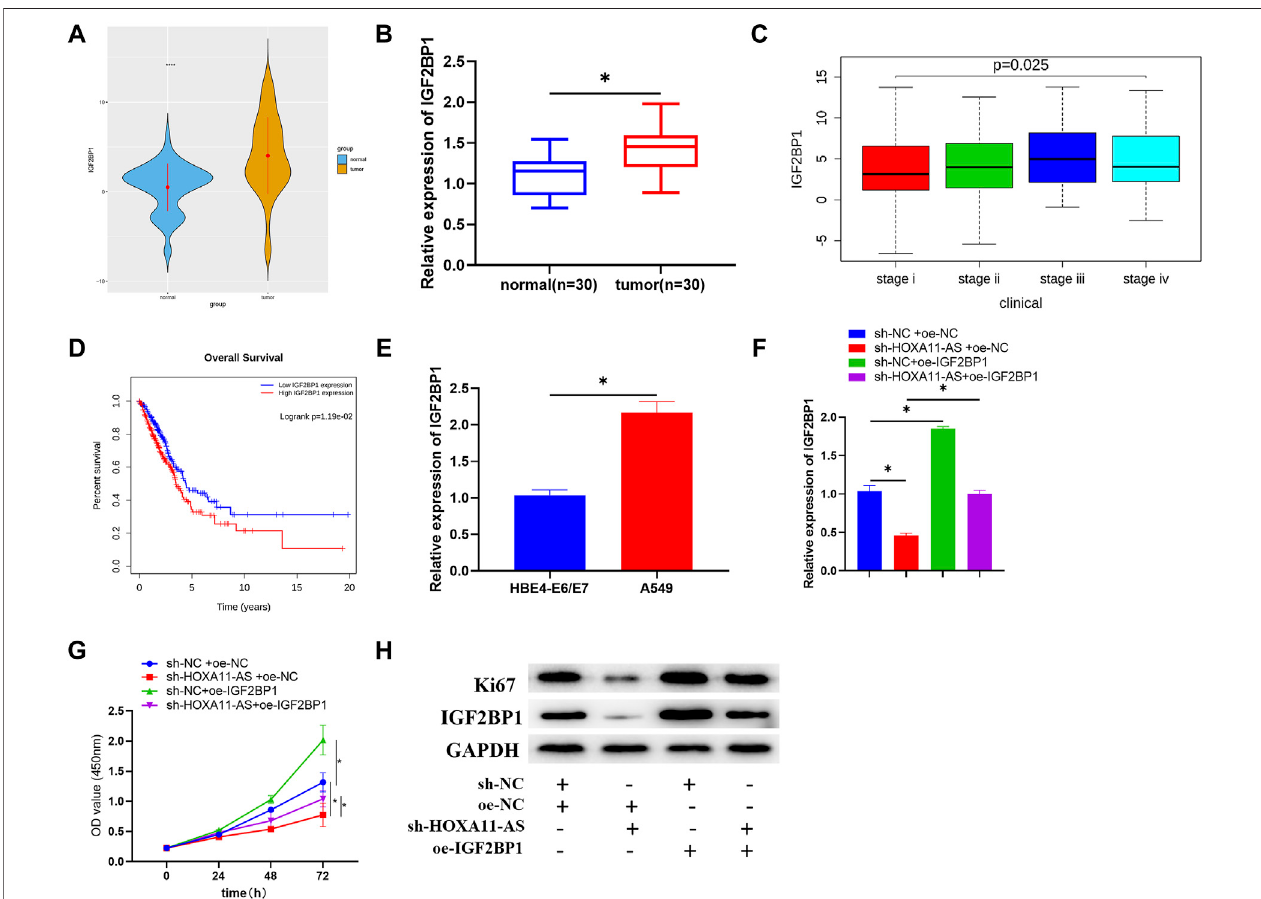
FIGURE 5 | IGF2BP1 is upregulated in LUAD cells, and the inhibition of IGF2BP1 can mitigate the promotion of overexpressed HOXA11-AS on LUAD cell proliferation. (A) Expression of target gene IGF2BP1 in normal and tumor group was depicted in boxplot (blue refers to normal tissue, orange refers to tumor tissue). (B) Expression of IGF2BP1 in tumor tissue ( n = 30) and adjacent normal tissue ( n = 30). (C) Expression of IGF2BP1 in various stages of LUAD (stage i: n = 279; stage ii: n = 124; stage iii: n = 85; stage iv: n = 26). (D) Relationship between IGF2BP1 and survival rate was estimated with red for high IGF2BP1 expression and blue for low IGF2BP1expression. (E) qRT-PCRwasconducted for theassessment ofIGF2BP1mRNAin normalcell lineHBE4-E6/E7andLUADcell lineA549. (F) IGF2BP1 mRNA in transfected cells was evaluated in qRT-PCR assay. (G) By carrying out CCK-8 assay, cell viability in each group was estimated. (H) Through Western blot, the expression of proliferation of Ki67 as well as IGF2BP1 in each group of cells was tested; * p <